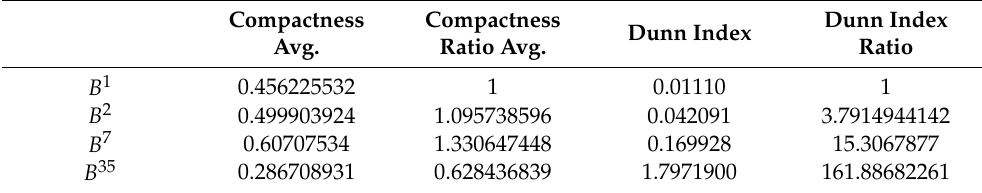
Table 2. Compactness, Donn index as we increase ultrametricity. Spiral dataset.